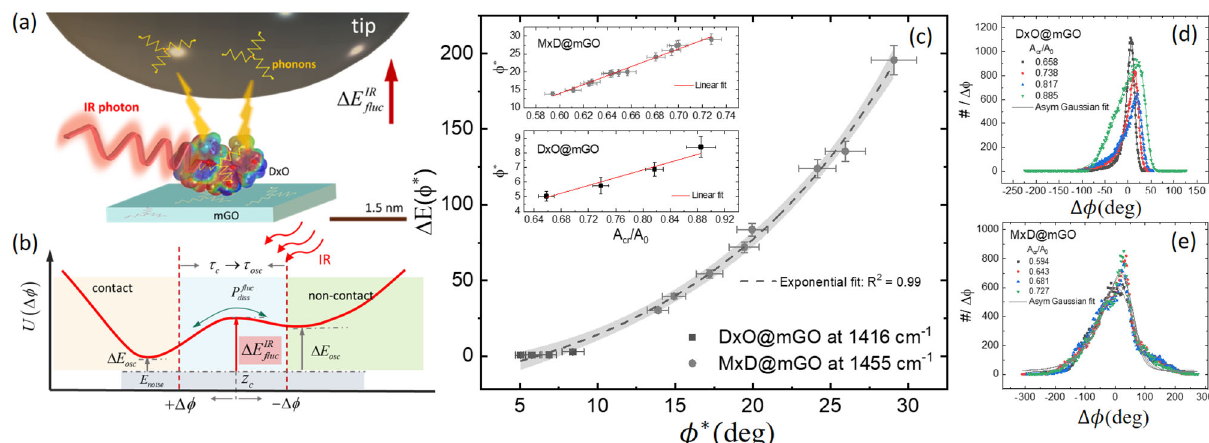
Fig. 8 Contact resonance-enhanced infrared atomic force microscopy schematic. a Illustration of IR-induced fl uctuational enhancement. b describes the change in interaction potential function as a function of external IR excitation that brings about higher fl uctuational probability transitions. c Energy dissipation probability as a function of phase contrast, the gray areas represent 98% con fi dence bands; Insets depict the apparent phase-contrast as function of the contact resonance amplitude (CR-Amplitude) ratios. d , e shows the IR phase-contrast characteristics in DxO@mGO and MxD@mGO, respectively. Error bars are computed from the standard deviations of the measured phase histograms and the dynamic amplitude A